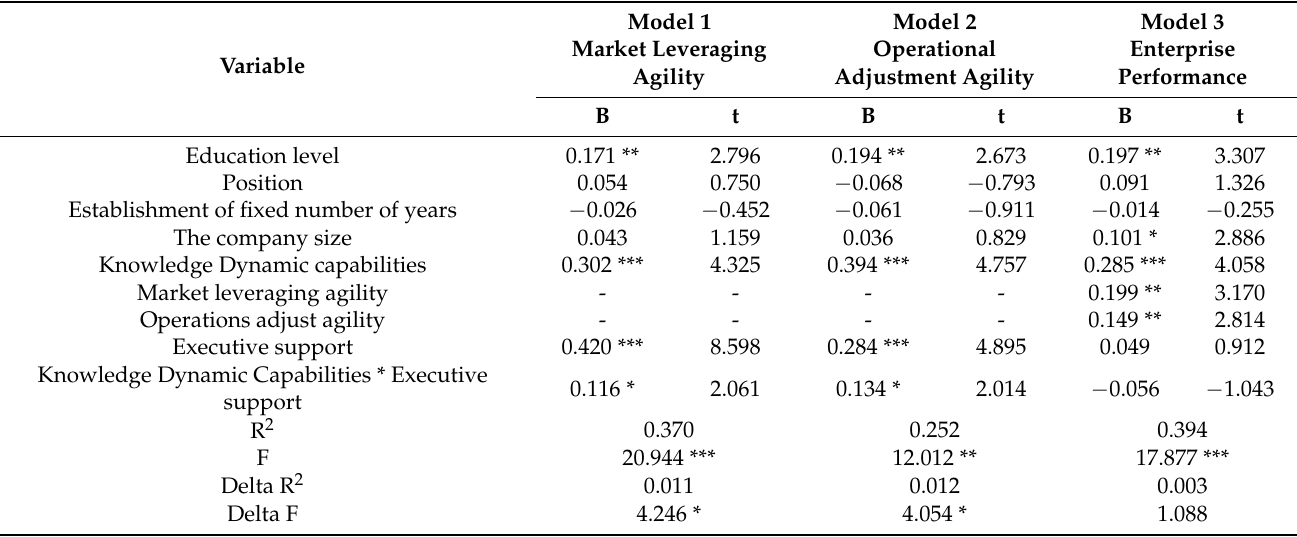
Table 6. Test table of moderating